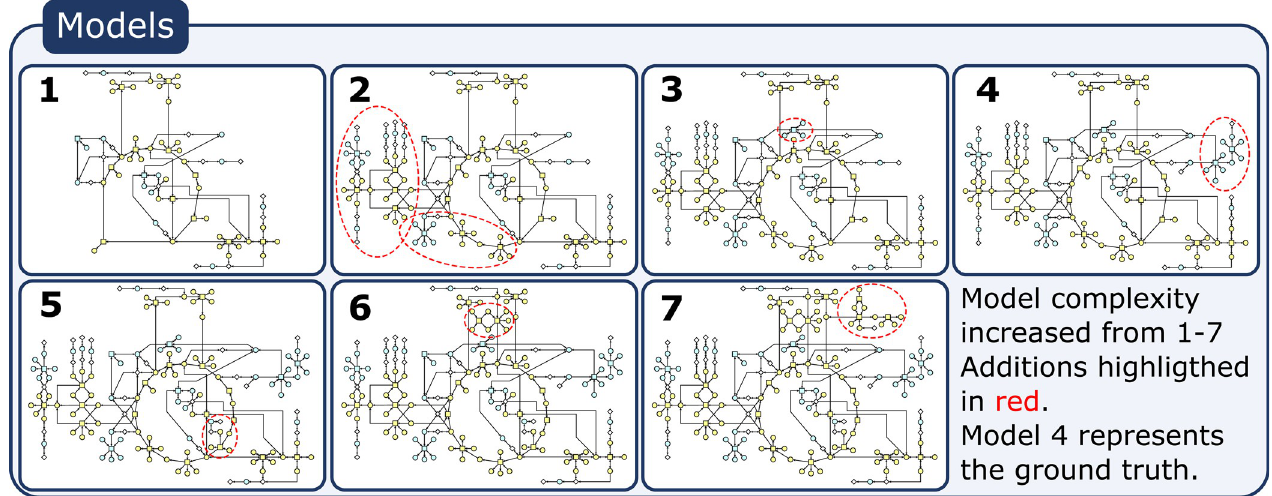
Fig 7. Seven different model structures included in the simulated EMU 13 C MFA example with simulated data. The added component to each model structure, compared to the previous model, with slightly smaller complexity, is found inside the red circle. The true model used to simulate the data is model nr 4. Detailed descriptions for each model can be found in the supplementary material (S1 Table).